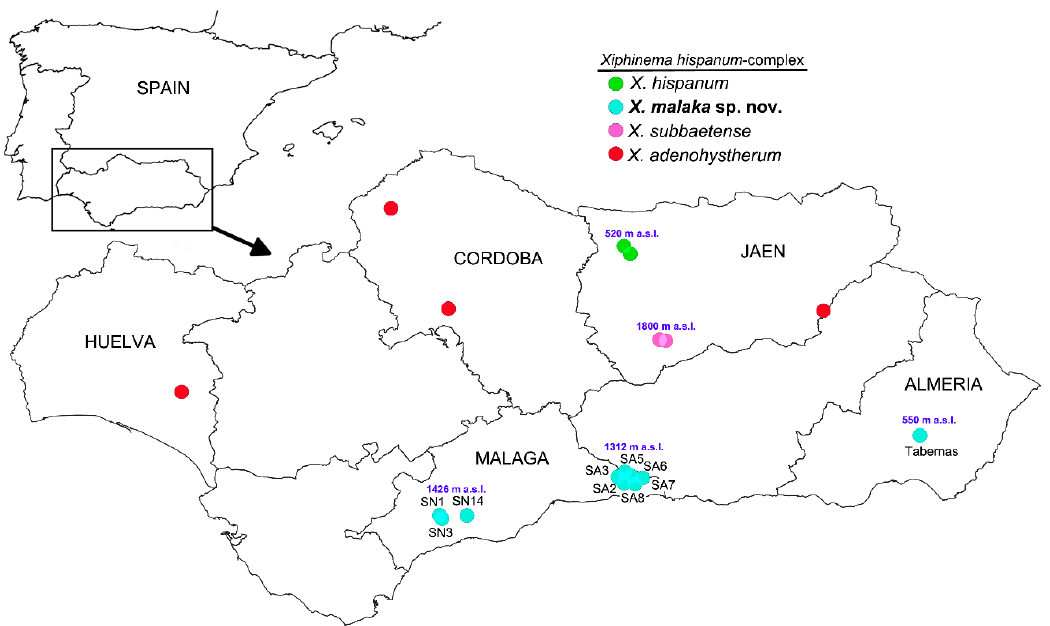
Figure 1. Geographic distribution of Xiphinema hispanum -complex species and locations of sampling sites of which the recovered isolates of the new species were characterized morphometrically and molecularly. Arrow indicates the location of Andalusia in the Iberian Peninsula.